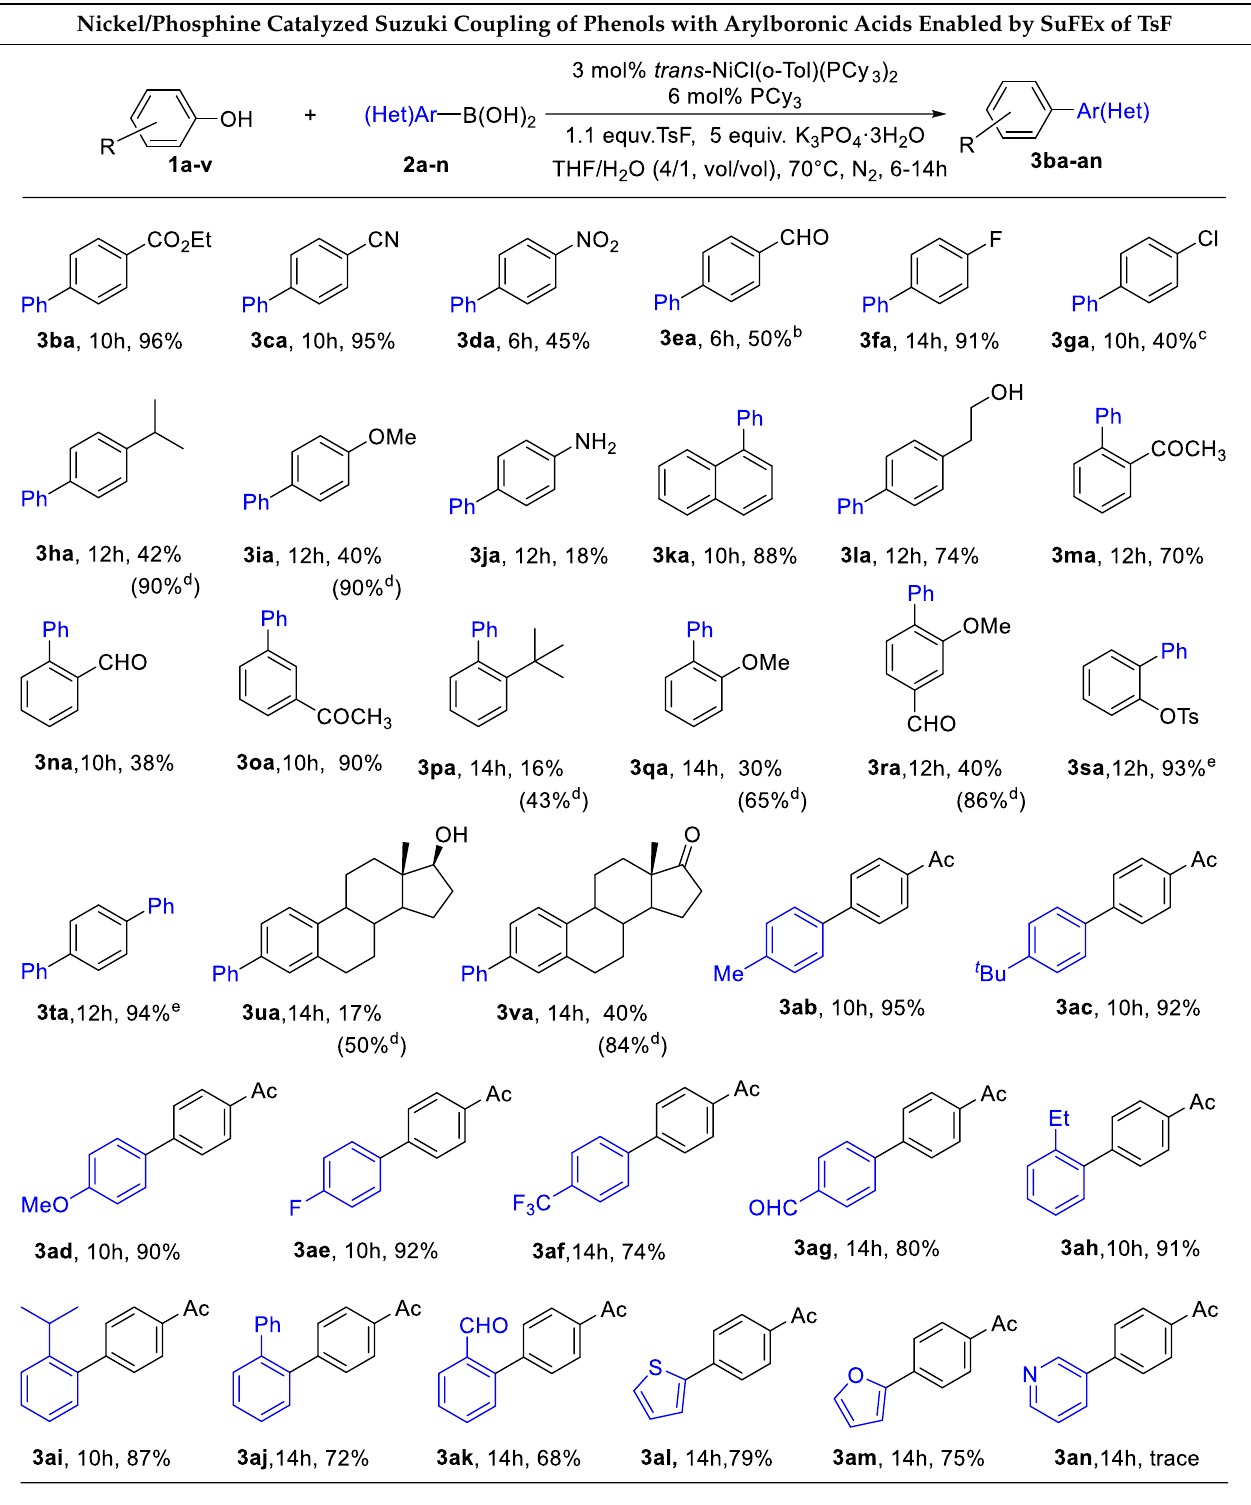
Table 2. Nickel/phosphine catalyzed Suzuki coupling of phenols with arylboronic acids enabled by SuFEx of TsF a .